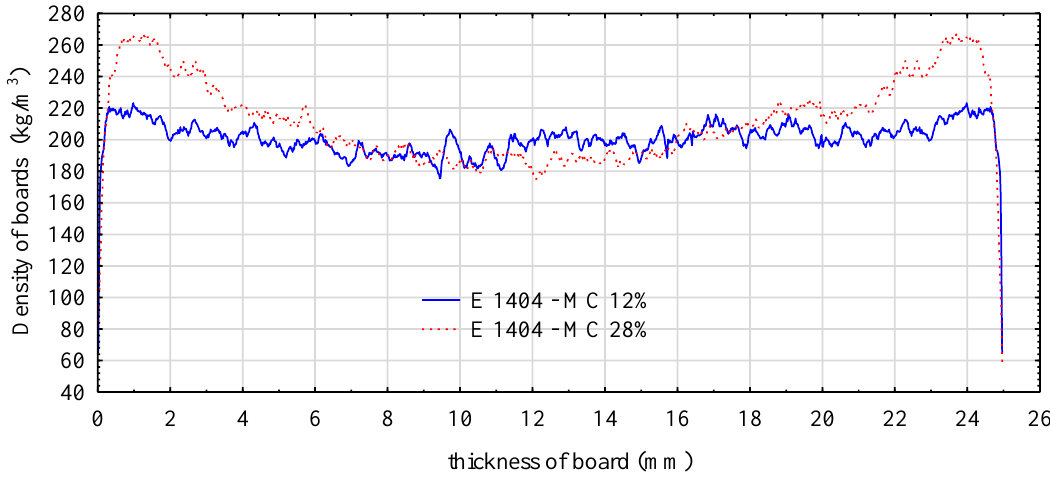
Figure 3. Density profiles of boards manufactured from pulp differing in initial moisture content. Panel E0 was selected for tests assessing the sound absorption coefficient. Although such panels did not exhibit the highest strength parameters, their manufacturing process ultimately seems the easiest to perform, since the fibers used to form the mat contain the lowest amounts of water. Figure 4 presents a graph for sound absorption of the analyzed panel. The most advantageous behavior is observed for this panel for frequencies over 2000 Hz, although it may also be stated that advantageous values of the sound absorption coefficient are obtained in the frequency range of 500 to 1600 Hz. It is difficult to assess the effect of the bonding agent itself on sound absorption, since the recorded values are very similar to those for conventional lightweight insulation fiberboards or panels from natural fibers [50,51].